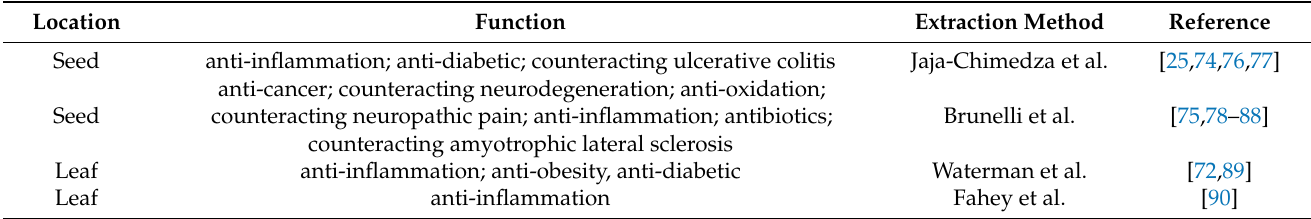
Table 2. The extraction methods and functions of